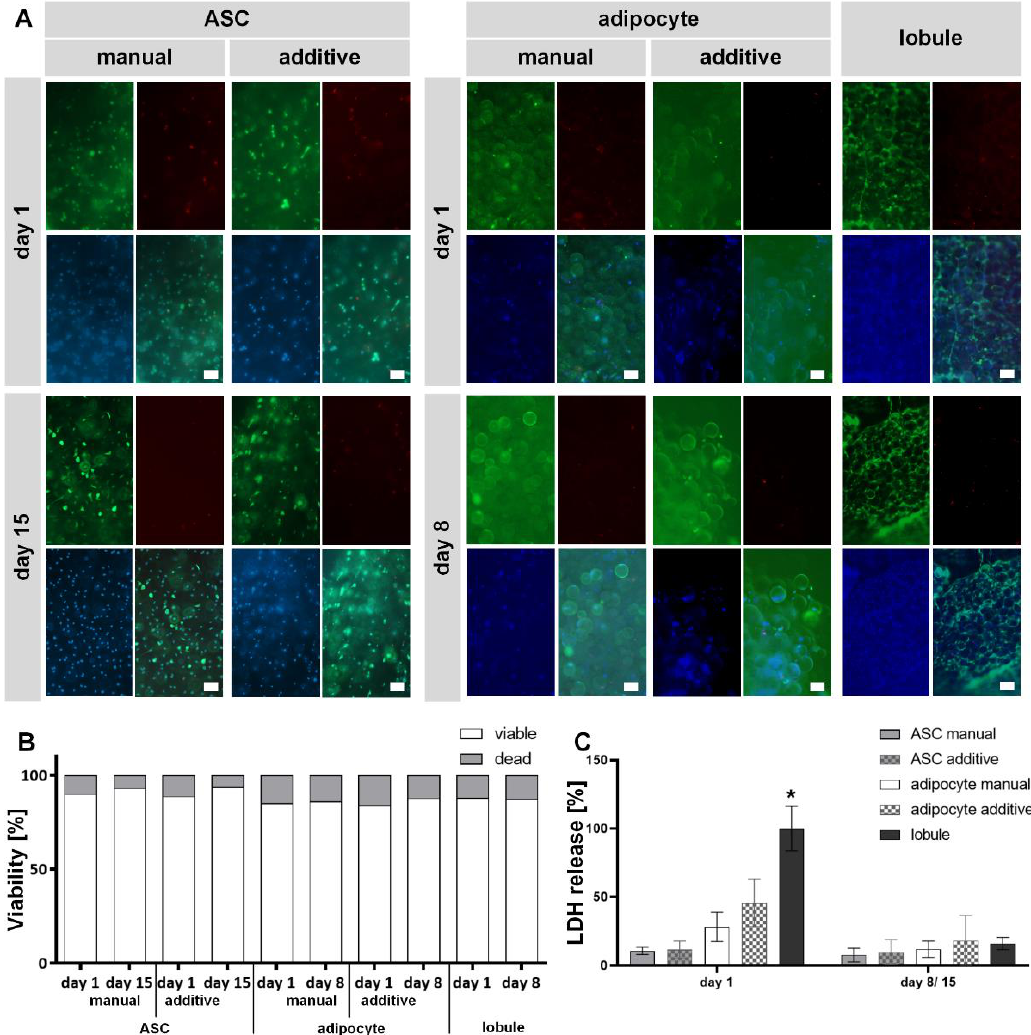
Figure 5. Viability analysis of encapsulated diffASCs and mature adipocytes in GelMA compared to explanted adipose tissue. ( A ) Live-dead staining (viable cells in green by FDA, dead cells in red by propidium iodide, cell nuclei in blue by Hoechst) of manual and bioprinted GelMA hydrogels containing ASCs or mature adipocytes on days 1 and 8 or 15, respectively, compared to lobules on days 1 and 8. Top left FDA, top right PI, bottom left Hoechst, and bottom right merged. Scale bar 100 µM ( B ) semi-quantitative viability analysis of counted viable and dead cells per condition. N = 9 ( C ) normalized LDH release of manual and additively manufactured GelMA hydrogels containing ASCs or mature adipocytes, respectively, relative to lobules. * α ≤ 0.05